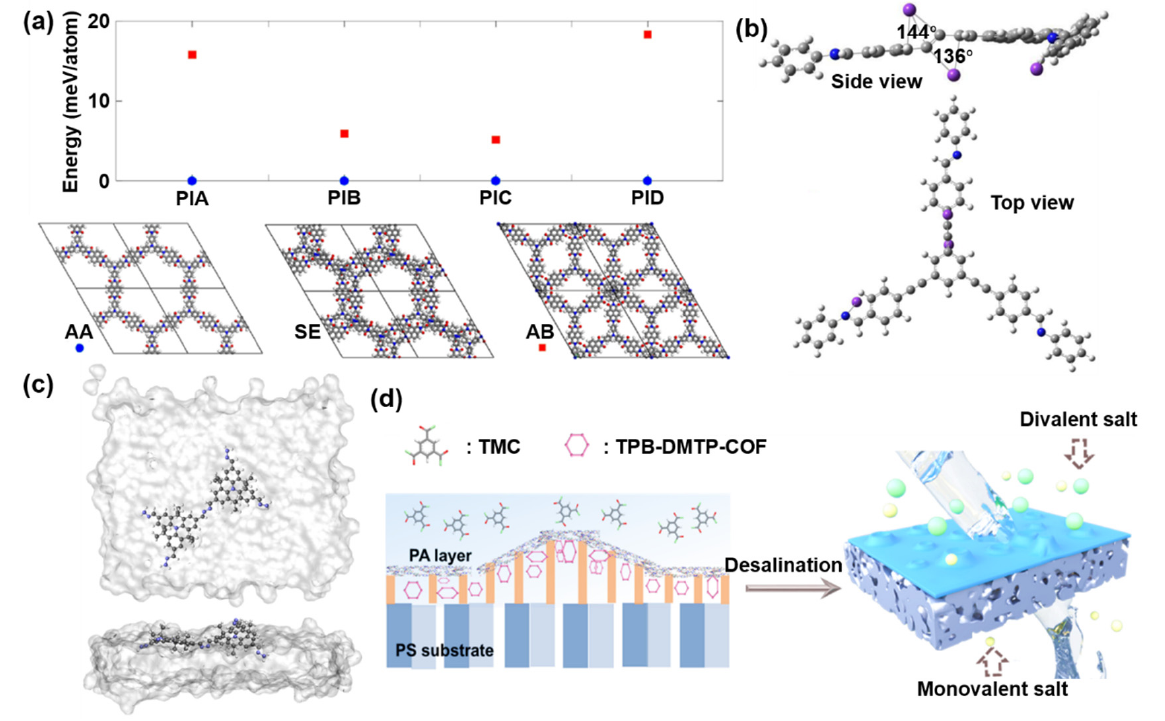
Figure 5. Theoretical assistances explanation for conductive COFs. ( a ) Energy difference between the AA eclipsed, AB staggered stacking for the four COFs, an illustration of the AA eclipsed, AB staggered and an example of serrated stacking (SE) [77]. Copyright 2021, American Chemical Society. ( b ) Visualization of optimized geometry of three potassium ions bound to radical anionic TAEB-PI [83]. Copyright 2021, American Chemical Society. ( c ) Top and lateral views of the final configuration of the azine-linked BTPHA1 dimer at the air-water interface by using DFTB MD simulations [85]. Copyright 2021, American Chemical Society. ( d ) Mechanism of the separation process of the COF-modulated thin-film nano-composite membrane [86]. Copyright 2022, American Chemical Society.